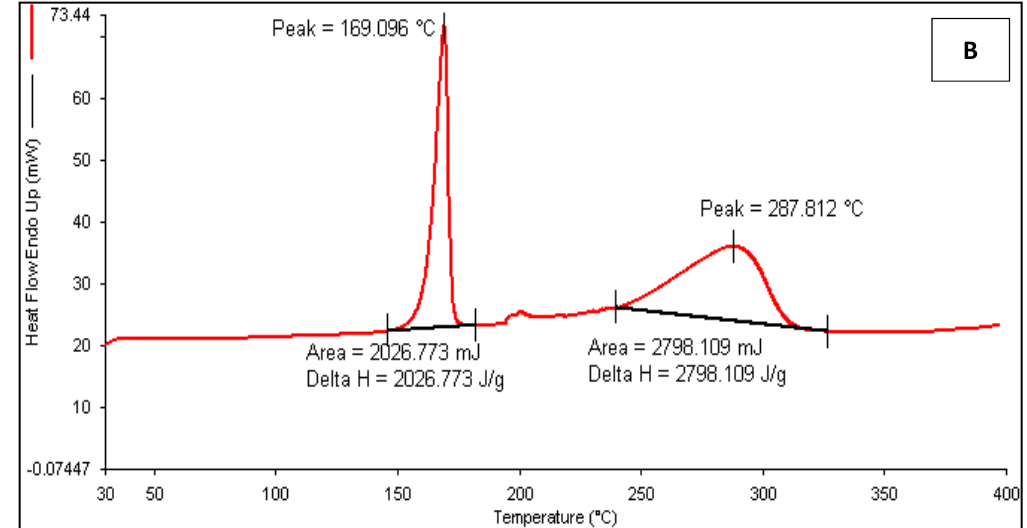
Figure 5. Di ff erential scanning calorimetry (DSC) thermogram of ( A ) ATZ and ( B ) Figure 5. Differential scanning calorimetry (DSC) thermogram of ( A ) ATZ and ( B ) ATZ-NLC.